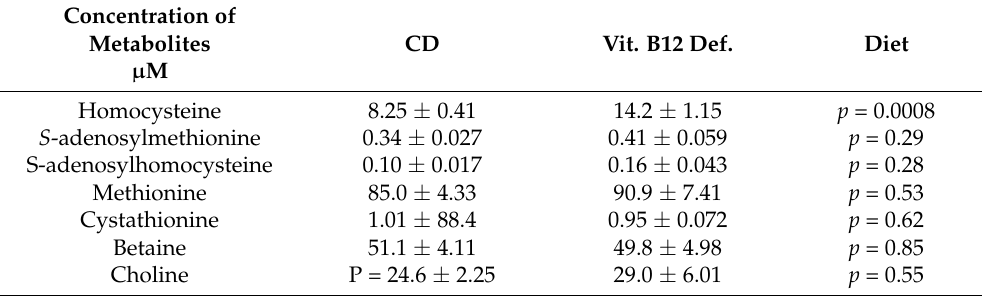
Table 1. One-carbon metabolite concentrations in plasma of control and vitamin B12 deficient diet females 1 . Concentration of